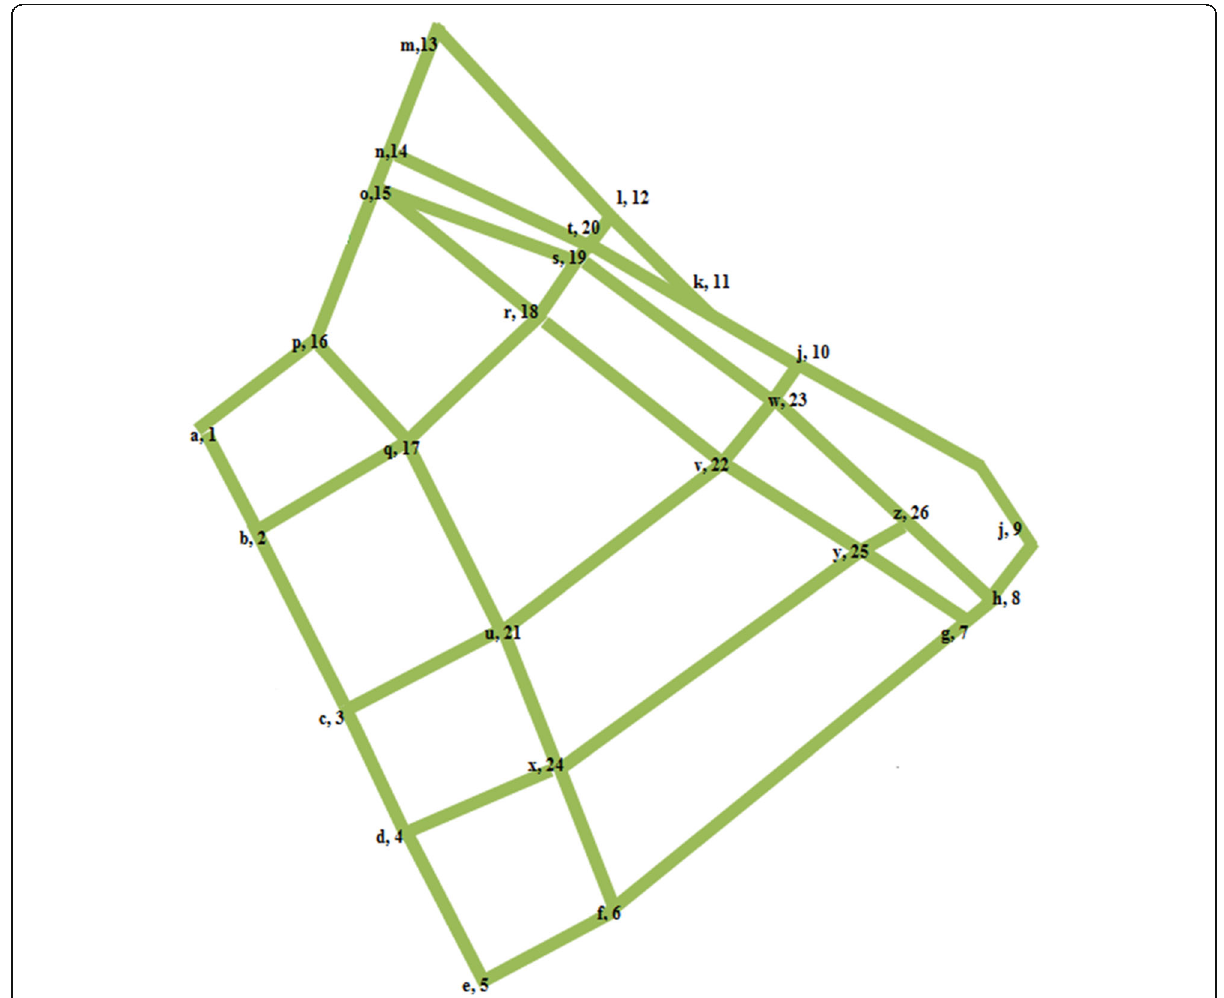
Fig. 16 Roads graph network in district 7,